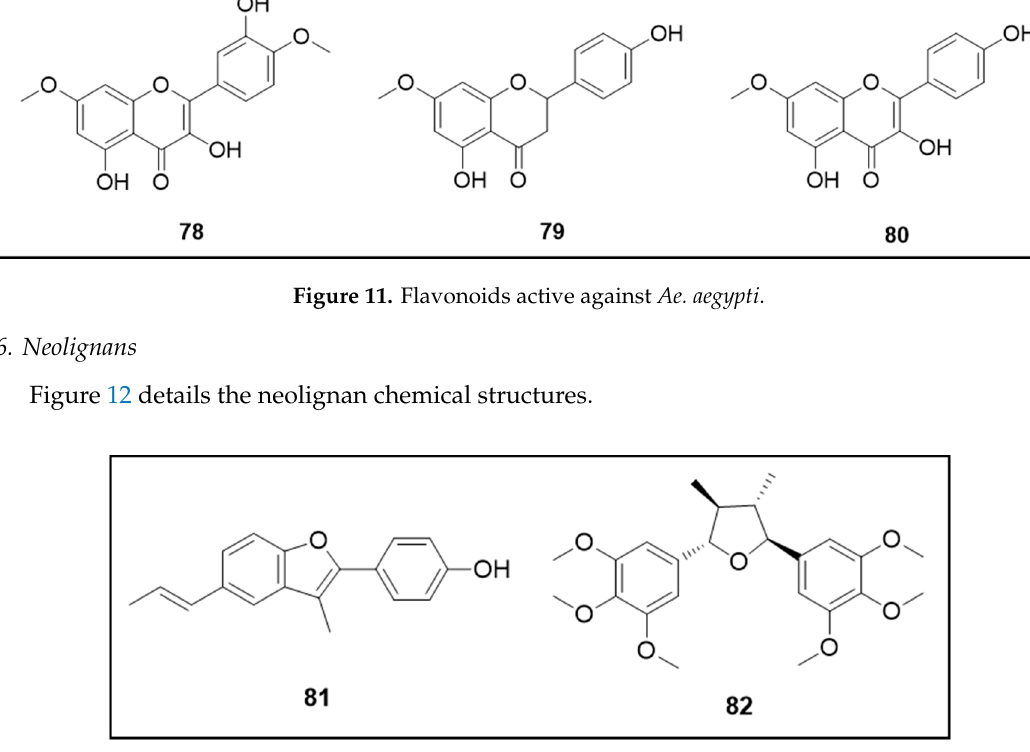
Figure 12. Neolignans active against Ae. aegypti .